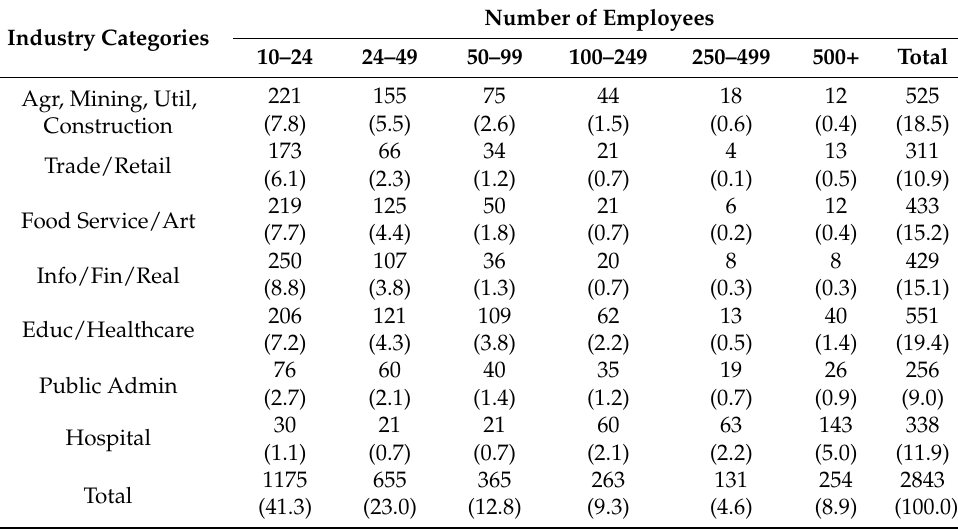
Table 1. WHA Sample by industry and establishment size